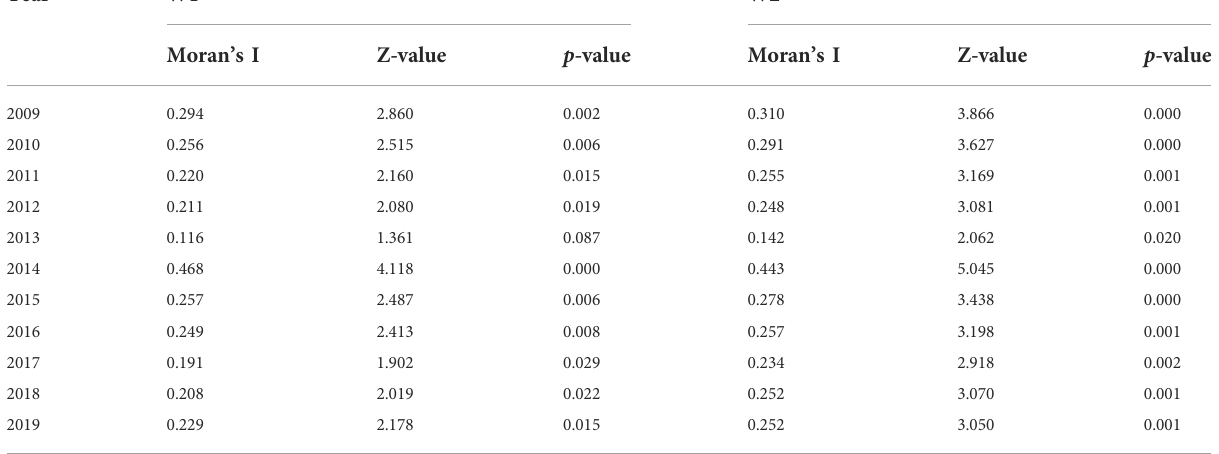
TABLE 4 Global Moran ’ s I of agricultural carbon emission intensity from 2009 to